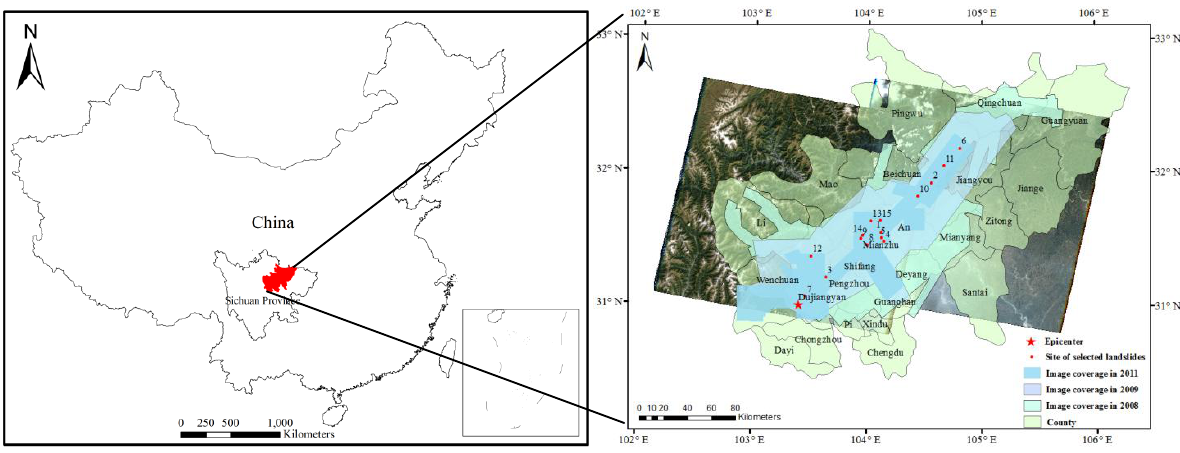
Figure 1. Airborne imagery across the earthquake region (background: Landsat TM image in 2007).